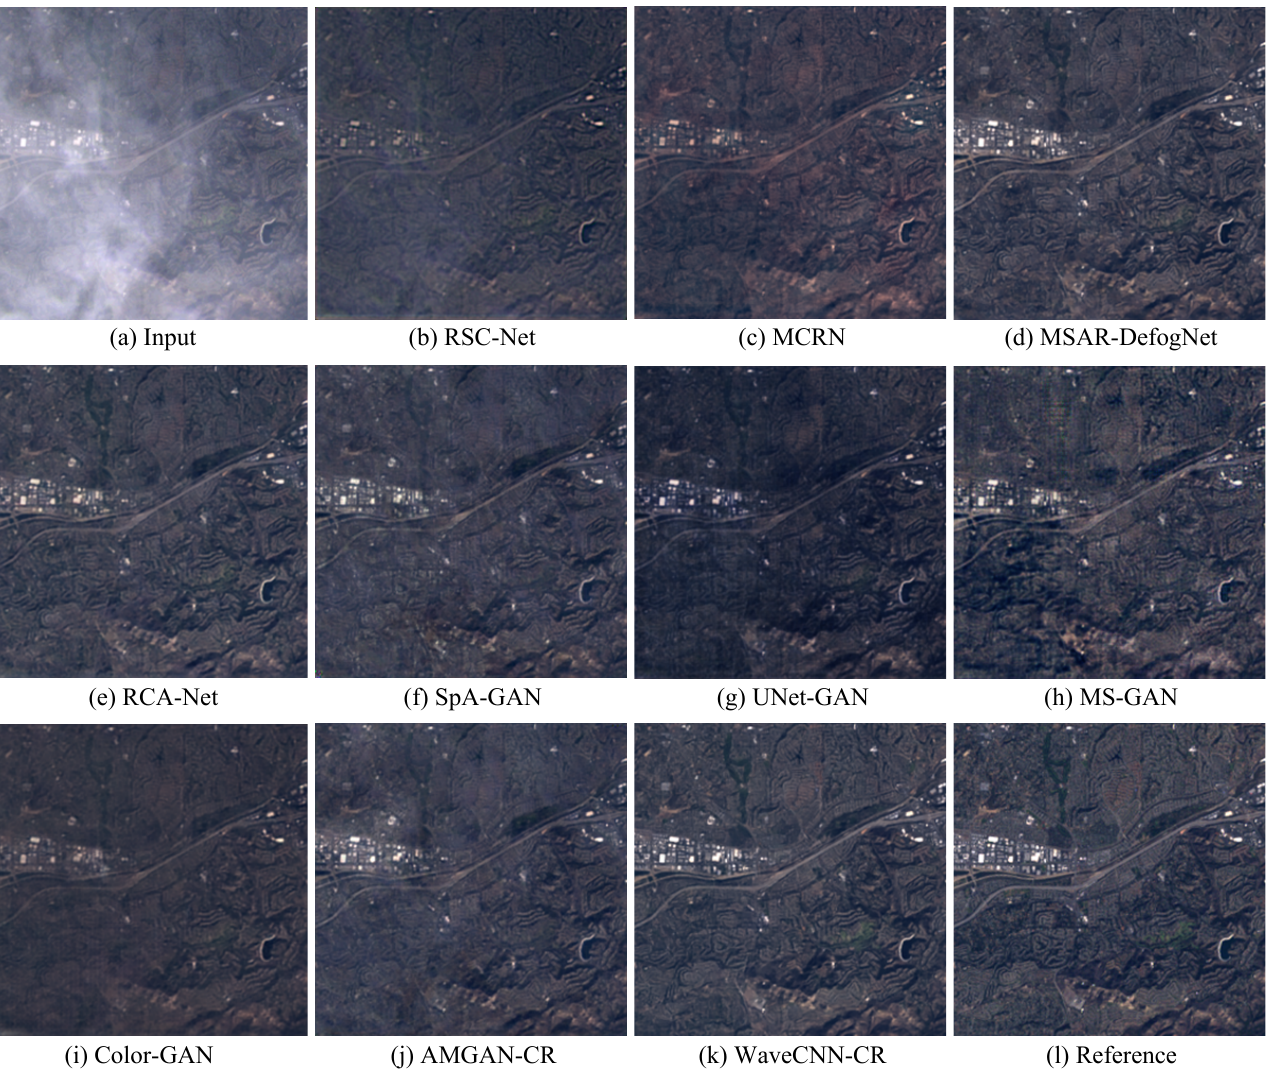
Figure 5. Visual comparisons on the T-CLOUD dataset: ( a ) input cloudy image; ( b – k ) results